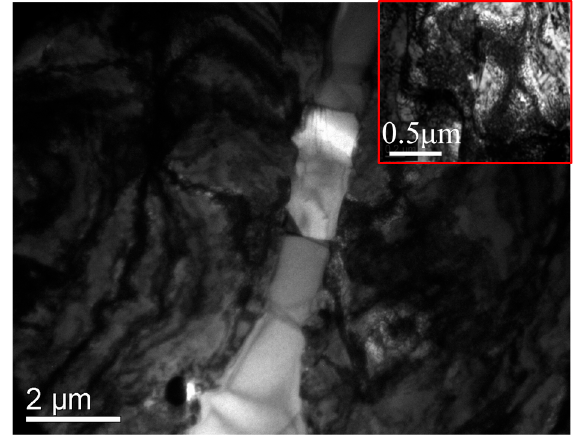
Figure 9. Dislocation structure around new DRX grains in 2707 HDSS deformed at 1050 °C and 10 s − 1 .